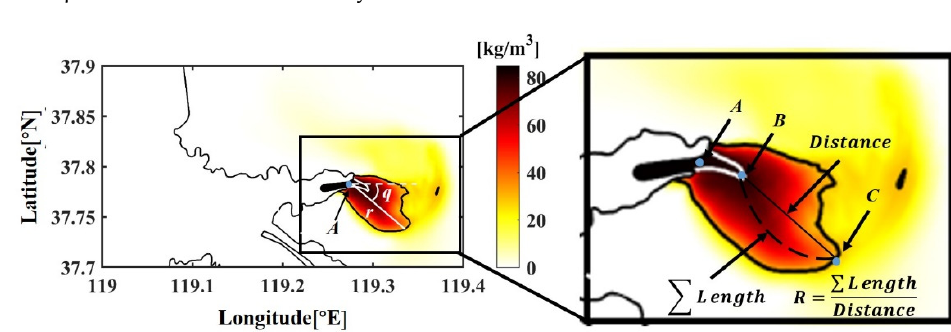
Figure 3. Path index of the hyperpycnal flow. Index r is the maximum distance between Point A and Point B; q is the runoff direction denoted by the angle between the eastward direction (i.e., white dash lines) and the line linking Points A and B. Note that Point A is the river mouth, Point B is the position on the isoline where SSC = 80 kg/m 3 , whereas Point C is the position on the isoline where SSC = 30 kg/m 3 . R is the curved distance between Points B and C divided by the straight distance between Points B and C.